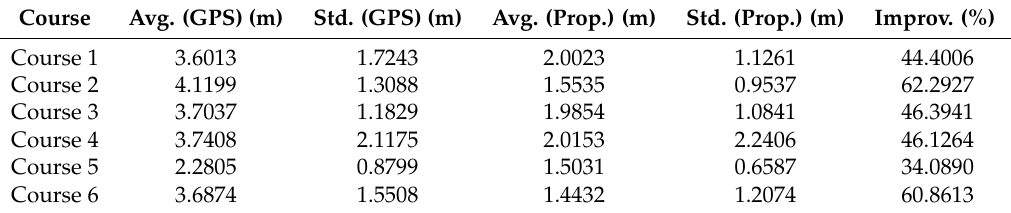
Table 2. Comparison results.